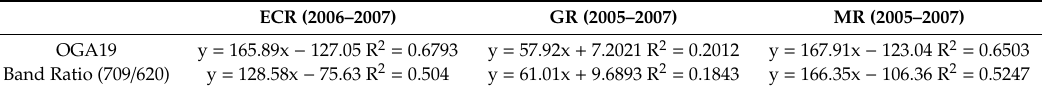
Table 8. Tuned models for OGA19 and Band Ratio (709 / 620), values in bold indicate the highest R 2